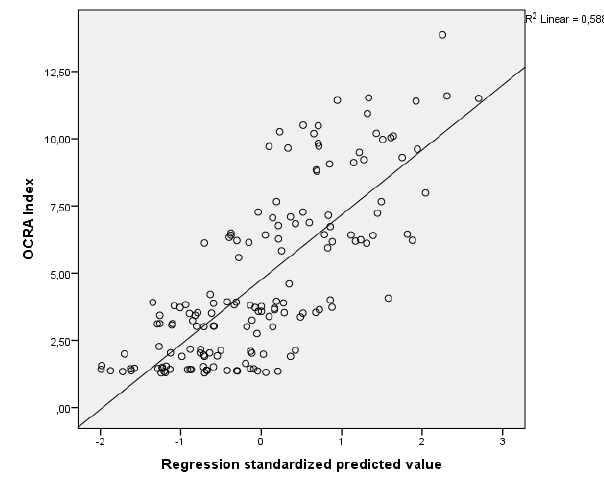
Figure 6. OCRA Index x Standardized predicted value, according to Equation (2).